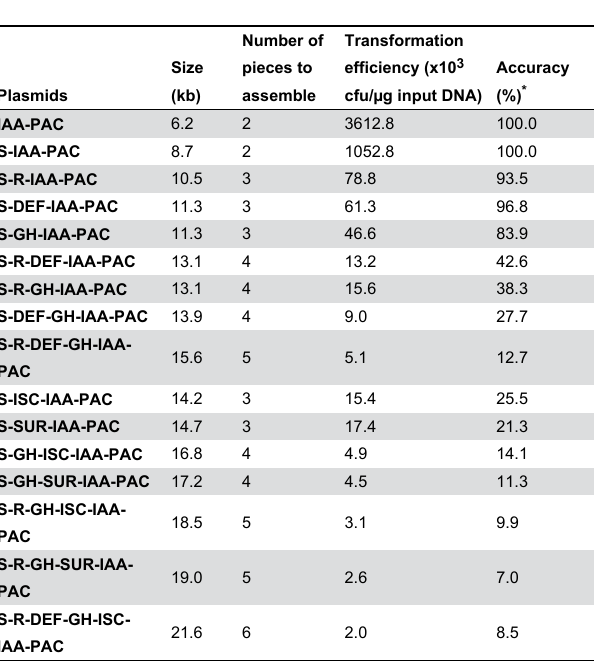
Table 1. Construction efficiency of the DXP pathway plasmids using CLIVA method.